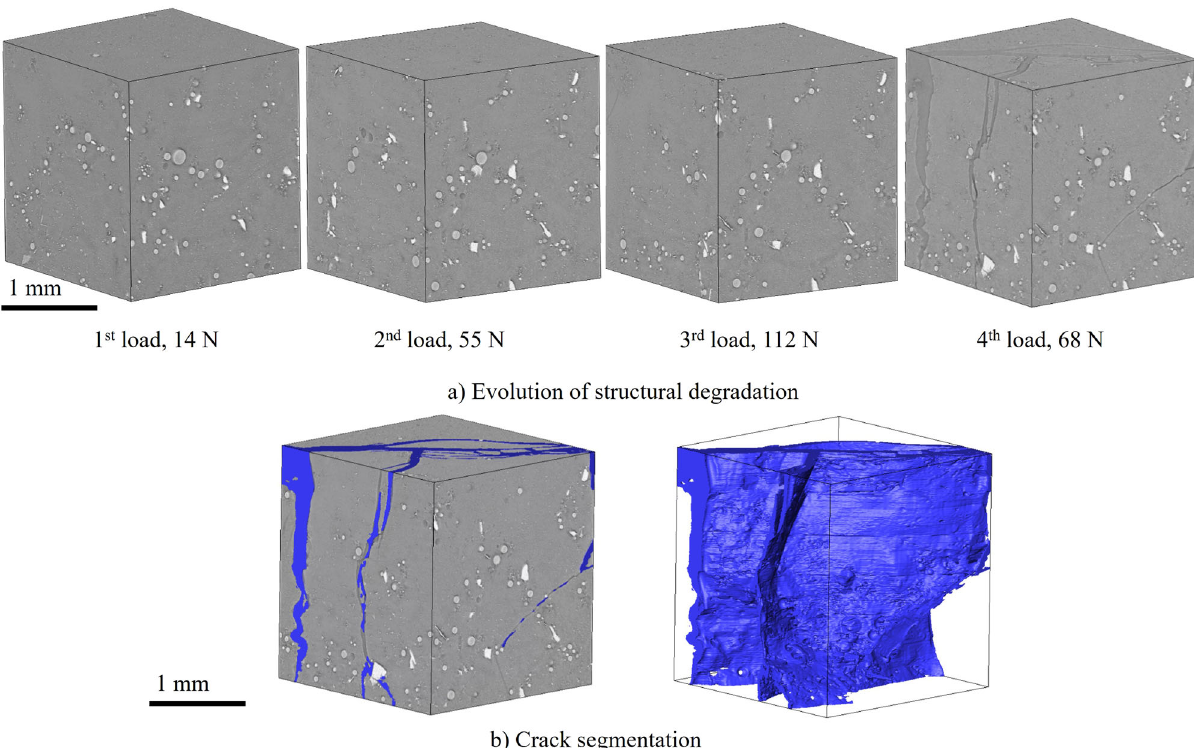
Fig. 4 Characteristic views. a 3D tomograms generated after performing XCT scans at several loading stages (from 14 N on the left to post failure 68N on the right) and b segmented 3D crack volume at failure.